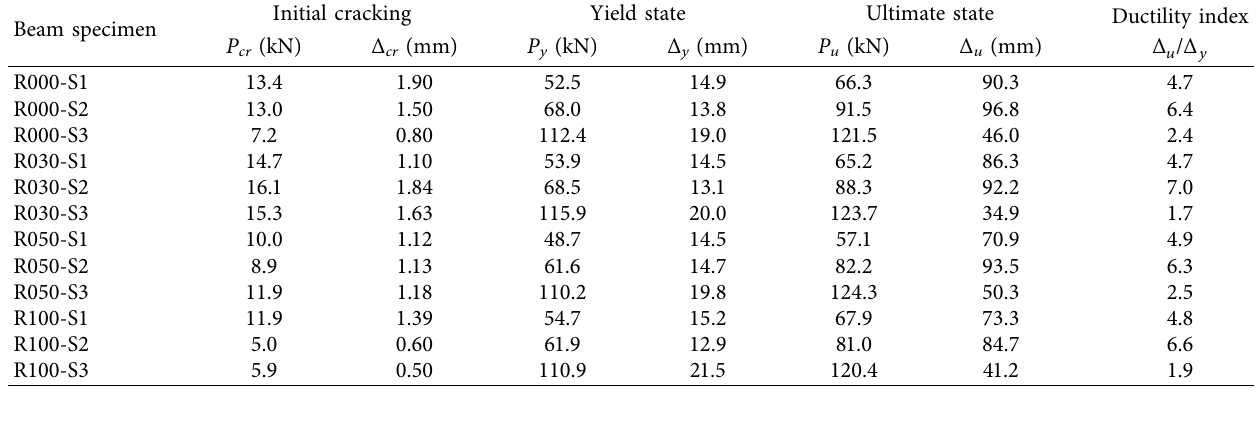
Figure 10: Effect of the rebar ratio on the load-deflection curves. (a) R000 series beams (control concrete). (b) R030 series beams (RCA content of 30%). (c) R050 series beams (RCA content of 50%). (d) R100 series beams (RCA content of 100%). Table 4: Experimental values of the cracking, yield, and ultimate